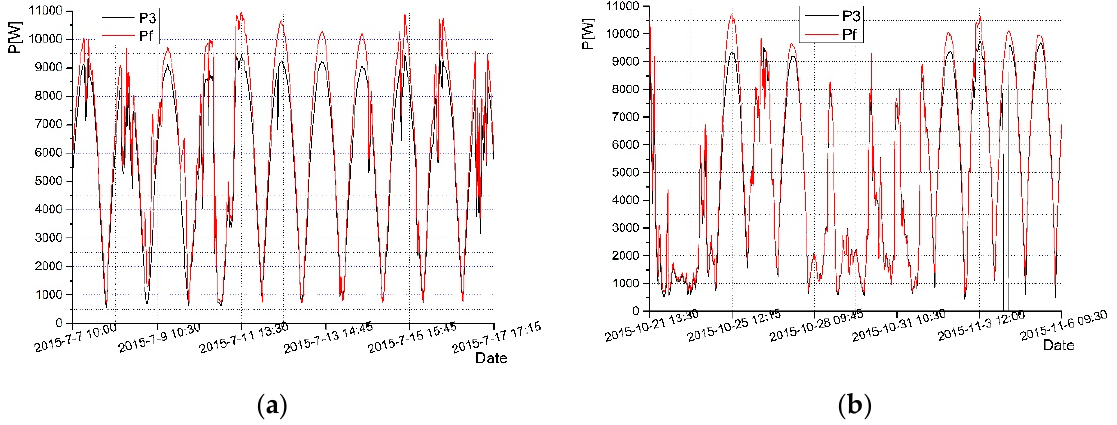
Figure 8. Comparison between the actual power output and simulated values for different seasons of the year 2015: (a) in July and (b) in October–November.